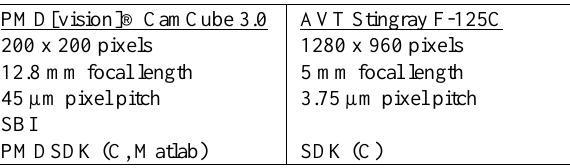
Table 1. Components of the multisensor system